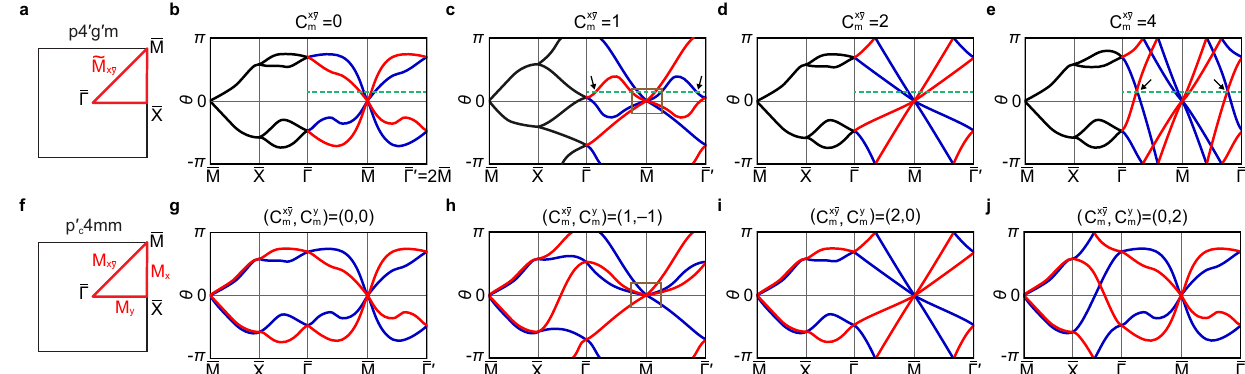
Fig. 2 Wilson loop spectra of 3D magnetic TCIs with (001)-surface MWGs p 4 0 g 0 m and p 0 4 mm . Classi fi cation of Wilson loop spectra, whose c connectivity is equivalent to the (001)-surface band structure, based on the MCNs C xy and C y . a – e Type-III TMDIs with MWG p 4 0 g 0 m on the m m . b – e Wilson loop spectra corresponding to b C xy (001) surface. a (001)-surface BZ. e M xy is the diagonal mirror used to de fi ne C xy ¼ 0 , c C xy ¼ 1 , m m m d C xy 2 , and e C xy 4 . For convenience, the position of the Dirac fermion at M is adjusted to be located at θ ( k ) = 0. The red (blue) lines m ¼ m ¼ . In correspond to Wilson bands with mirror eigenvalue + i ( − i ). The green dashed lines are the reference lines used to count the MCN C xy m ≠ 0 , the dispersion of the Dirac fermion can be chiral in each mirror sector along Γ - M - Γ 0 . Note that Γ 0 ¼ ð 2 π ; 2 π Þ . In b , where c – e , in which C xy m ¼ 0 , the Dirac fermion is nonchiral. In d , where C xy ¼ 2 , the reference line is crossed by two chiral (upward) modes with mirror C xy m m eigenvalue + i . In c , where C xy ¼ 1 , the dispersion is chiral along the entire Γ - M - Γ 0 line but locally looks nonchiral near the Dirac point. The m Wilson loop structure in c can be deformed into that in h by pushing the twofold crossing at Γ upward, which gives a locally chiral dispersion > 2 , a Dirac fermion must appear with other gapless surface states along the Γ - M - Γ 0 line [black arrows in e ]. f – j Type-IV TMDIs at M . When jC xy m j ; C y ; C y 4 mm on the (001) surface. f (001)-surface BZ. g – j Wilson loop spectra corresponding to g ðC xy 0 ; 0 Þ , h ðC xy 1 ; (cid:4) 1 Þ with MWG p 0 m m Þ ¼ ð m m Þ ¼ ð c